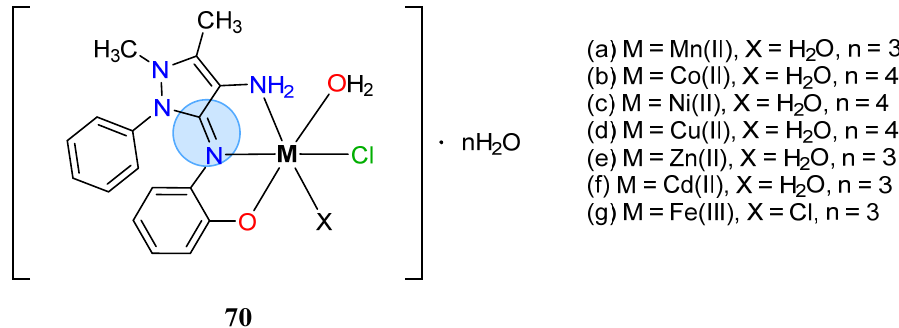
Figure 33. M(II) and Fe(III) complexes with a Schiff base ligand prepared via condensation of 4 ‐ aminoantipyrine and 2 ‐ aminophenol.